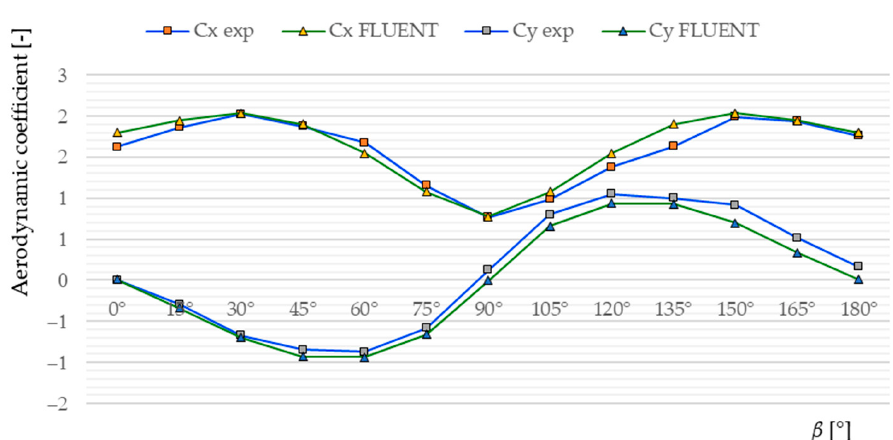
Figure 11. Comparison of the force coefficient C x and C y for the experimental and numerical results as function of angle of wind attack β in the case of configuration 2.